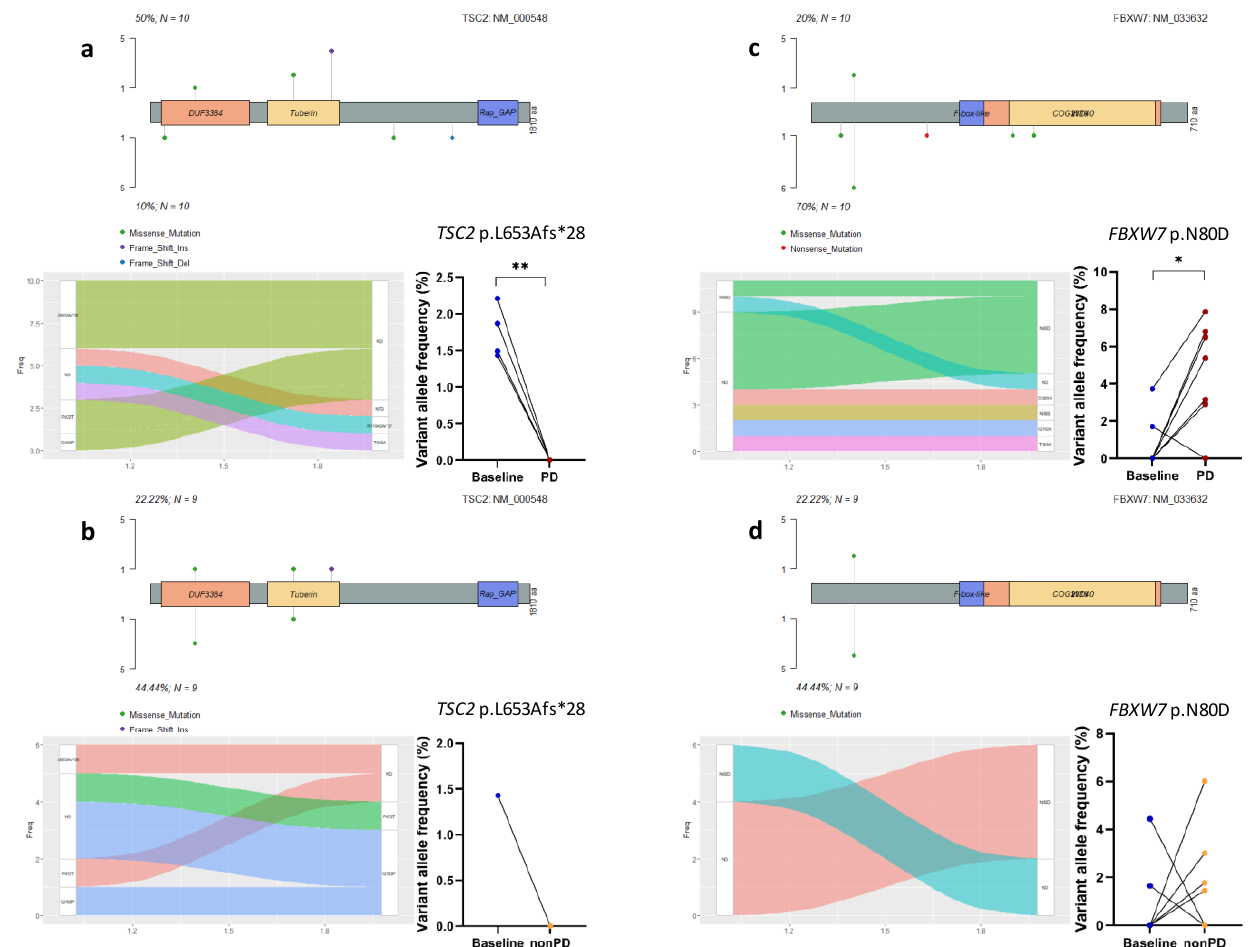
Figure 4. Changes in individual mutations in PI3K and Notch pathway genes and changes in variant allele frequency of a given mutation from baseline to follow-up as determined by analyzing paired samples. ( a , b ) show the changes in TSC2 mutations in baseline-PD pairs or baseline-nonPD pairs. ( c , d ) show the changes in FBXW7 mutations in baseline-PD pairs or baseline-nonPD pairs. PD: progressive disease; ND: not detected. * represents p < 0.05; ** represents p < 0.01.